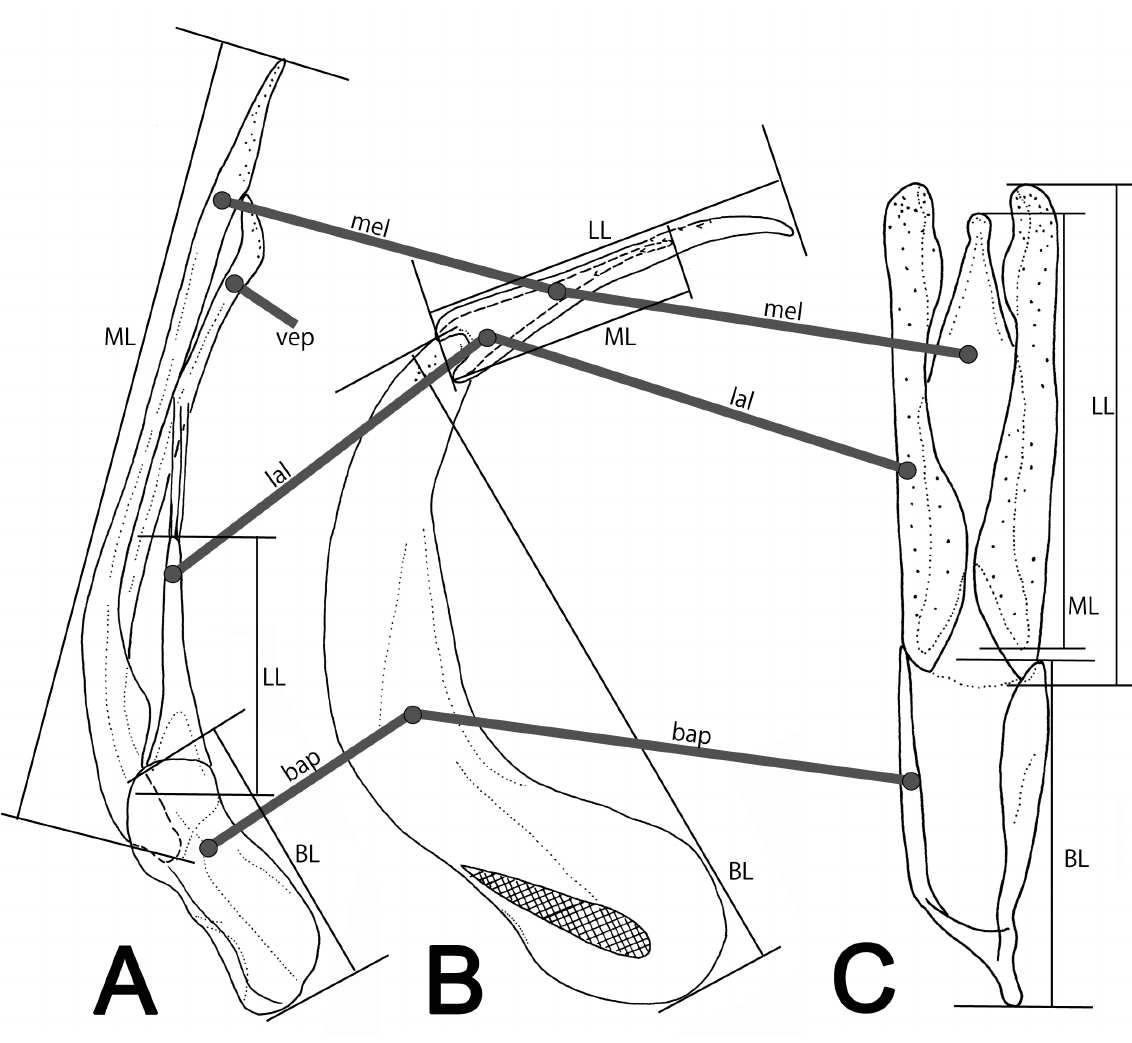
Fig. 1. Aedeagus, showing the terminology and the method of measurements. A . Mexico Spilman, 1972, left lateral view. B . Acontosceles Champion, 1924, left lateral view. C . Pseudeucinetus Heller, 1921, ventral view. Abbreviations: bap = basal piece; lal = lateral lobe; mel = median lobe; vep = ventral plate; BL = length of basal piece; LL = length of lateral lobe; ML = length of